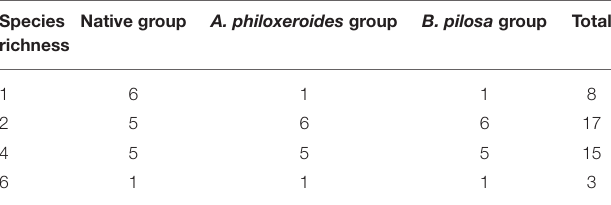
TABLE 2 | The number of species combinations used in the riparian zone of the Three Gorges Reservoir in China.